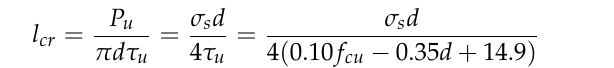
Figure 17. Comparison of calculation formulas of bond strength in China and abroad.